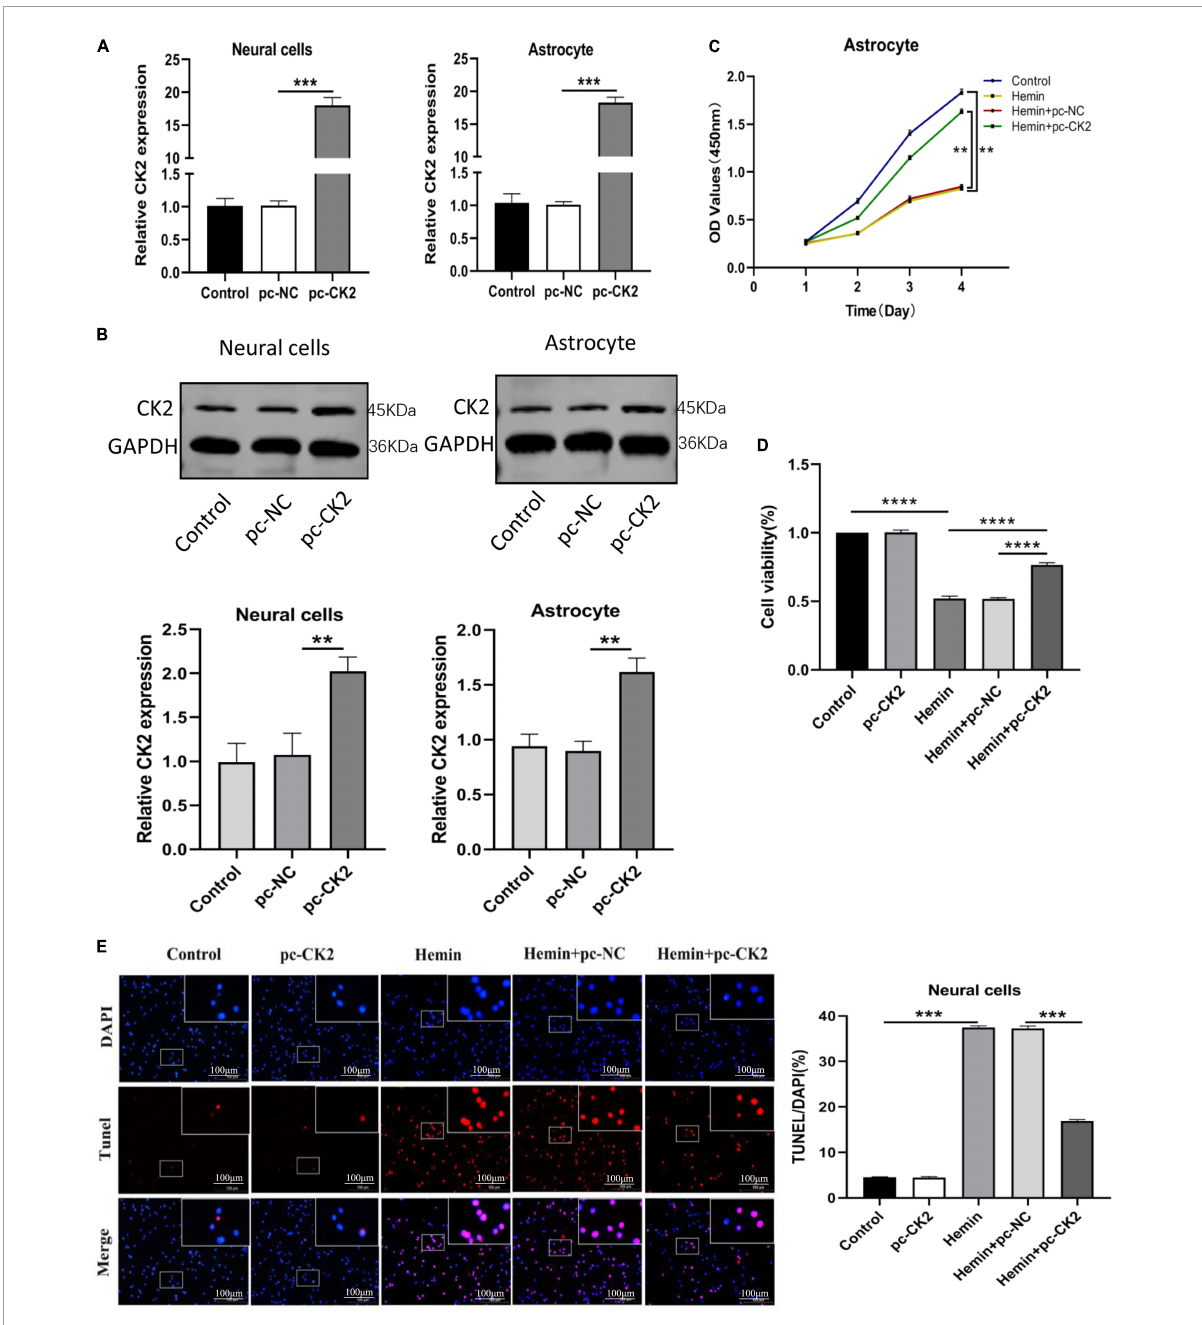
FIGURE5 Overexpression of CK2 facilitated the proliferation of astrocytes, and inhibited apoptosis of neurons. pc-CK2 was transfected into Hemin-treated neurons and astrocytes. (A) Expressions of CK2 in cells were detected using RT-qPCR. (B) CK2 expression was detected using Western blot. (C) Proliferation ability of astrocytes was detected using CCK8 assay. (D) The viability of neurons was quantified by CCK8 assay. (E) Cell apoptosis was measured using TUNEL staining. The cell experiment was repeated three times independently. Data were expressed as mean ± SD. ** p < 0.01, *** p < 0.001, **** p <